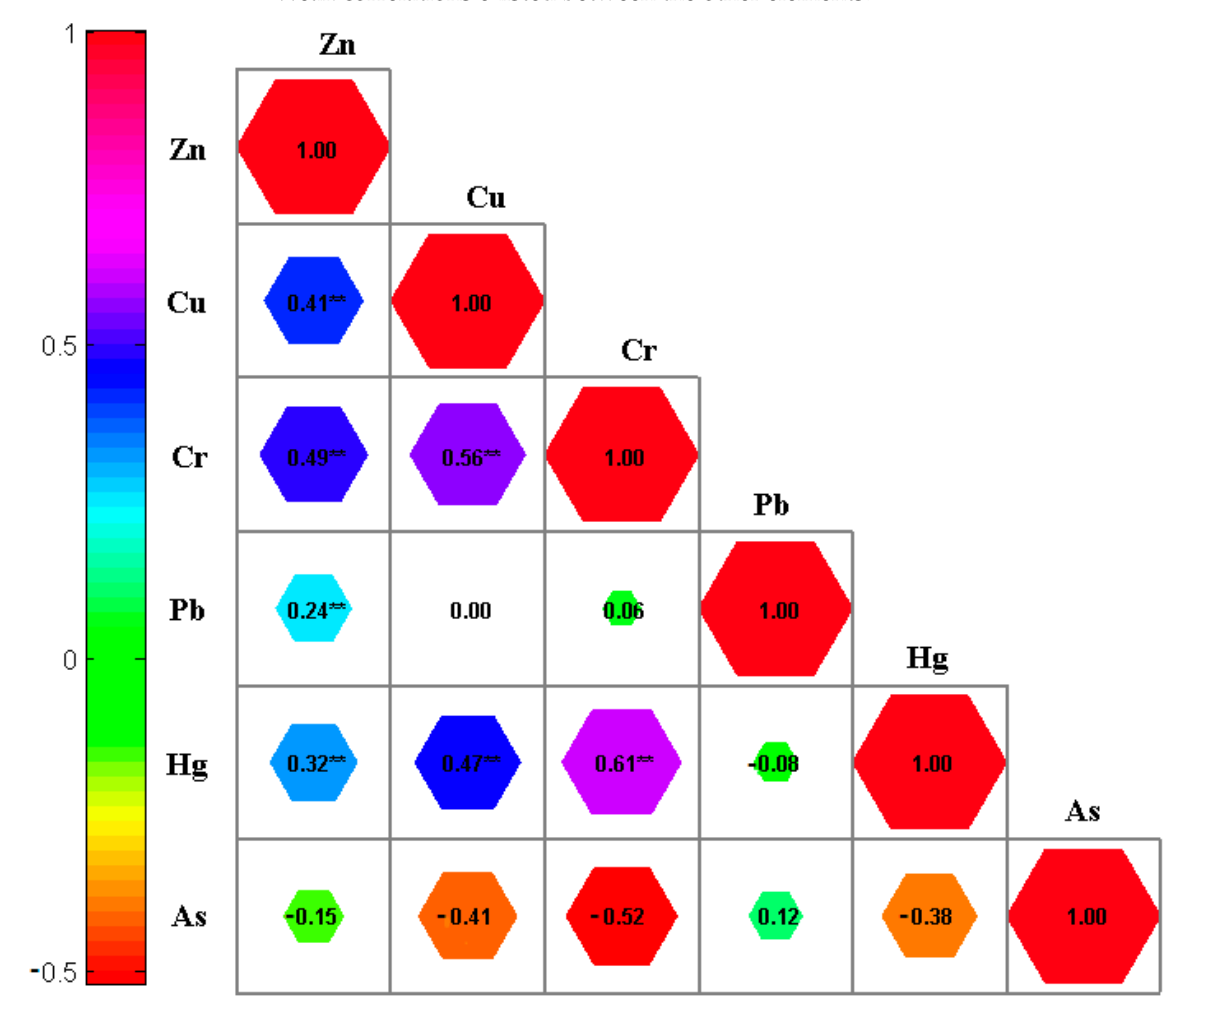
Figure 3. Correlation coefficients of the heavy metals in the soil. Note (** Significant correlation at 0.05 level).